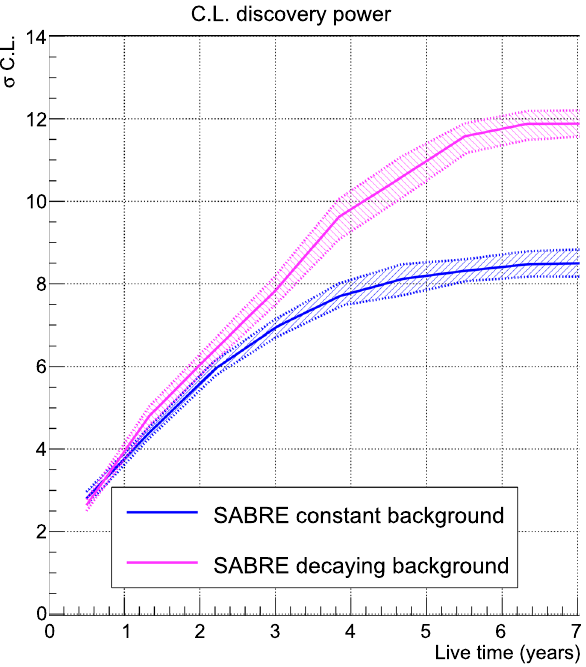
Fig. 9 Discovery power of SABRE for a constant and decaying back- ground modelled by Eq. 22